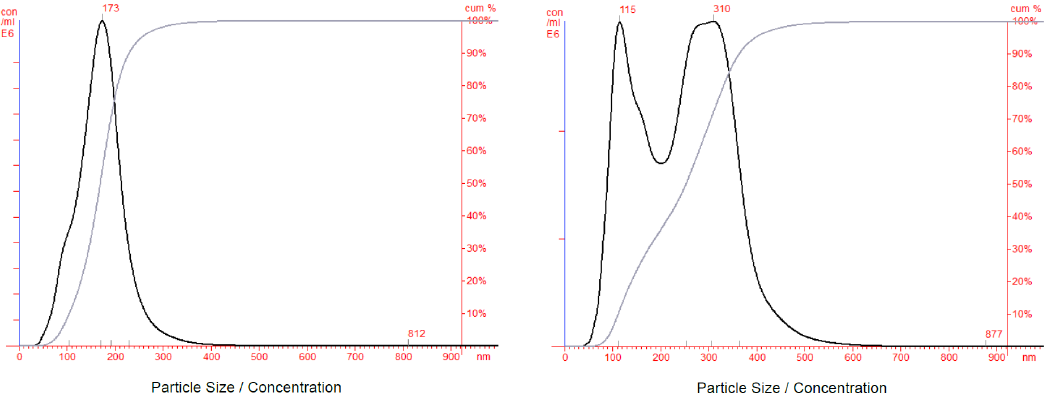
Figure 4. NTA histograms for mixtures of equal concentrations of two particle sizes. Left: 100 and 200 nm silica nanoparticles. Right: 100 and 300 nm silica nanoparticles. For the mixture of 100 and 200 nm particles, prepared concentration values are: for 100 nm particles: 2.98 × 10 8 particle/mL, for 200 nm particles: 2.99 × 10 8 particle/mL. Total measured concentration: 13.42 × 10 8 particle/mL. ± 10% corrected concentration for the 200 nm peak: 4.35 × 10 8 particle/mL. For the 100 nm particles, a noticeable peak could not be found in the size distribution that allows for the application of our correction